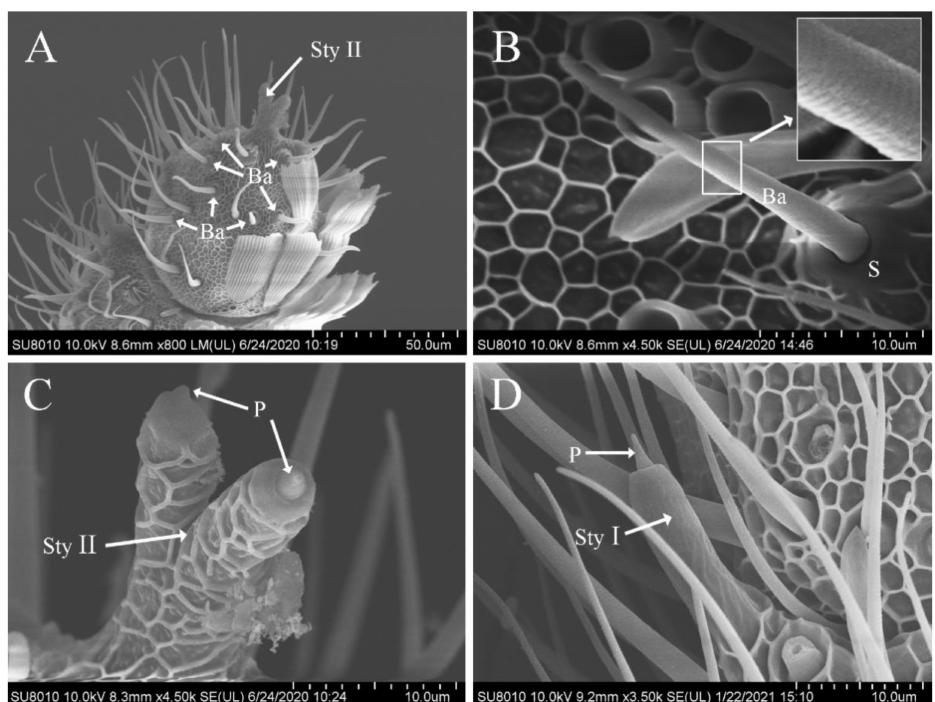
Figure 3. Scanning electron photomicrographs of sensilla basiconica and sensilla styloconica on the antennae of Dioryctria rubella . ( A ) Sensilla basiconica and sensilla styloconica (Sty II) on termi- nal antennae; ( B ) sensilla basiconica (boxes show partial enlargement); ( C ) sensilla styloconica II; ( D ) sensilla styloconica I. S, socket; P, peg